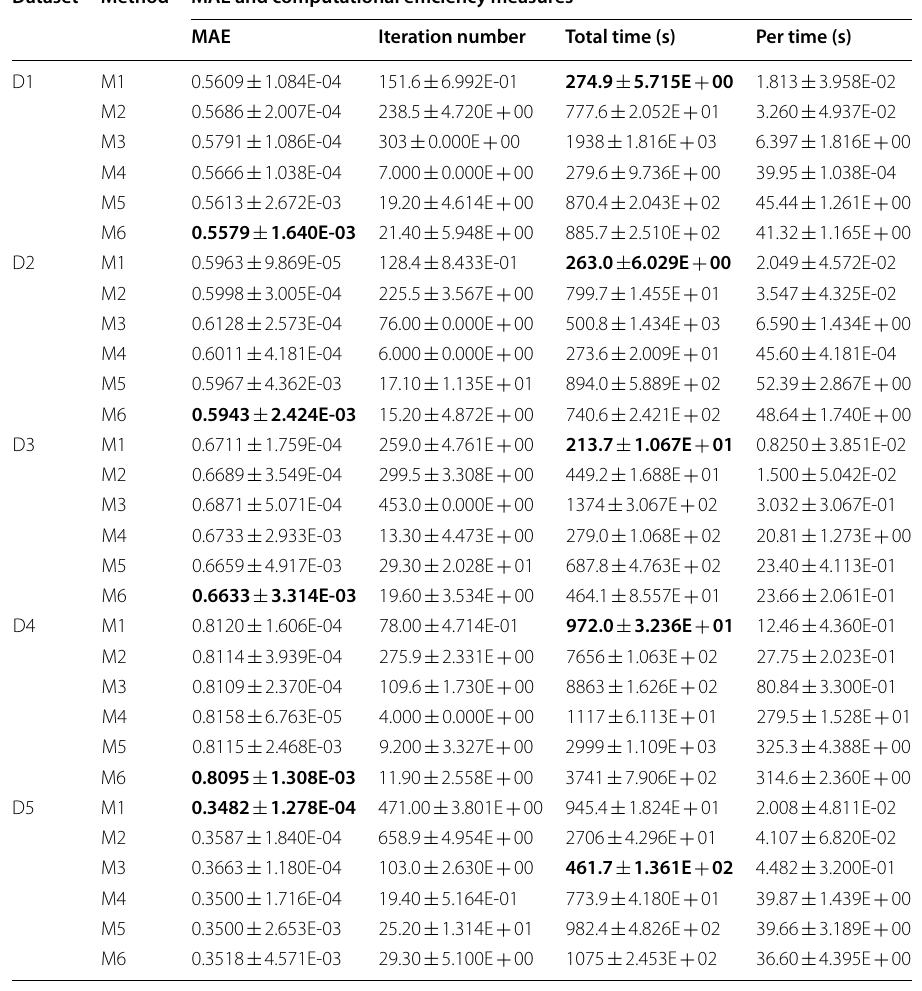
Table 5 M ean Mae results Dataset Method MAE and computational efficiency measures